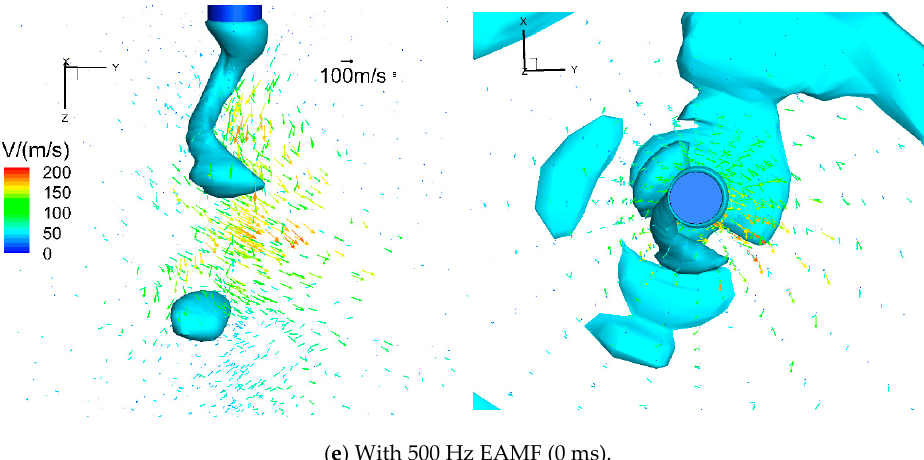
Figure 11. The arc plasma flow velocity vector for high-current GMAW under the influence of EAMF.